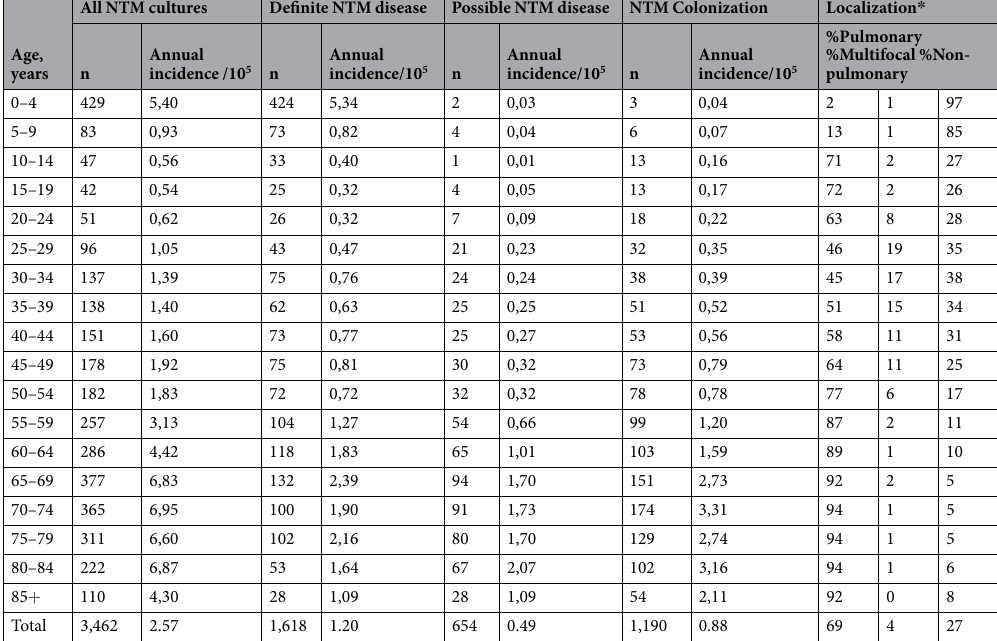
Table 3. Age standardized, annual incidence rates per 10 5 population and origin of NTM culture. NA: Not applicable. * Of all NTM